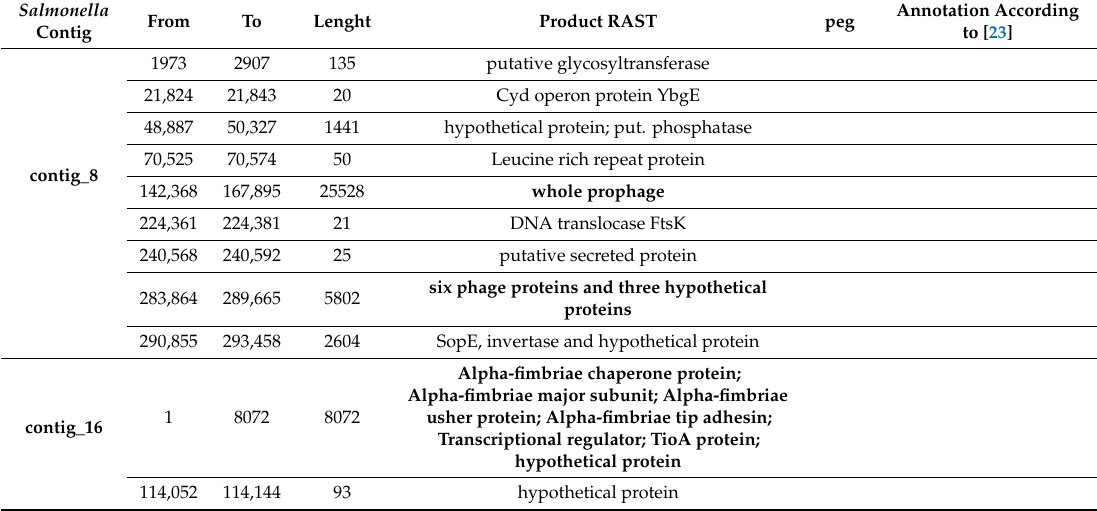
Figure A2. S144 adsorption to ( a ) S. Muenster (S394, wild type and A2, resistant strain) and ( b ) C. sakazakii (CS1, wild type and R3, resistant strain). Table A3. Identification of the phage receptor in Salmonella and Cronobacter . For both, we report the position on the contig (contig, from, to, length), the corresponding gene product according to the RAST annotation (product RAST) and the protein gene product (peg); for the genes involved in the O-antigen production, we also report the gene name and product according to the references [22,23]. Reads from S394 mutant mapped on S. Muenster S394 wt. Coverage < 5 reads, on contigs longer than 100,000 bp. In bold, the ORFs coding for prophages, fimbriae and O-antigen.